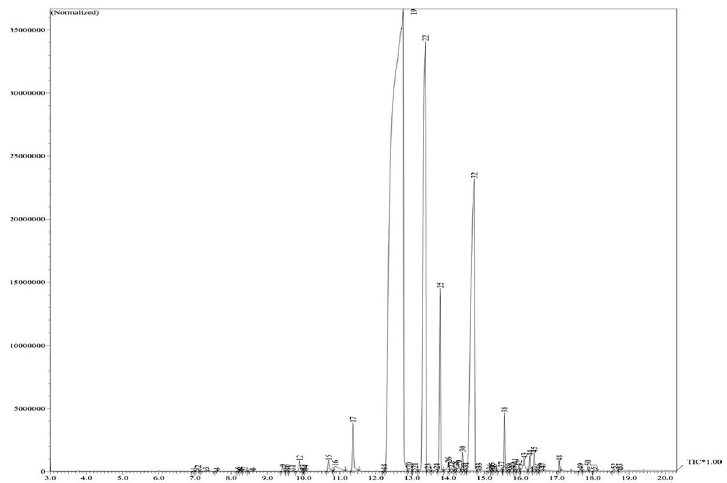
Fig. 1. A typical gas chromatogram of the constituents of essential clove